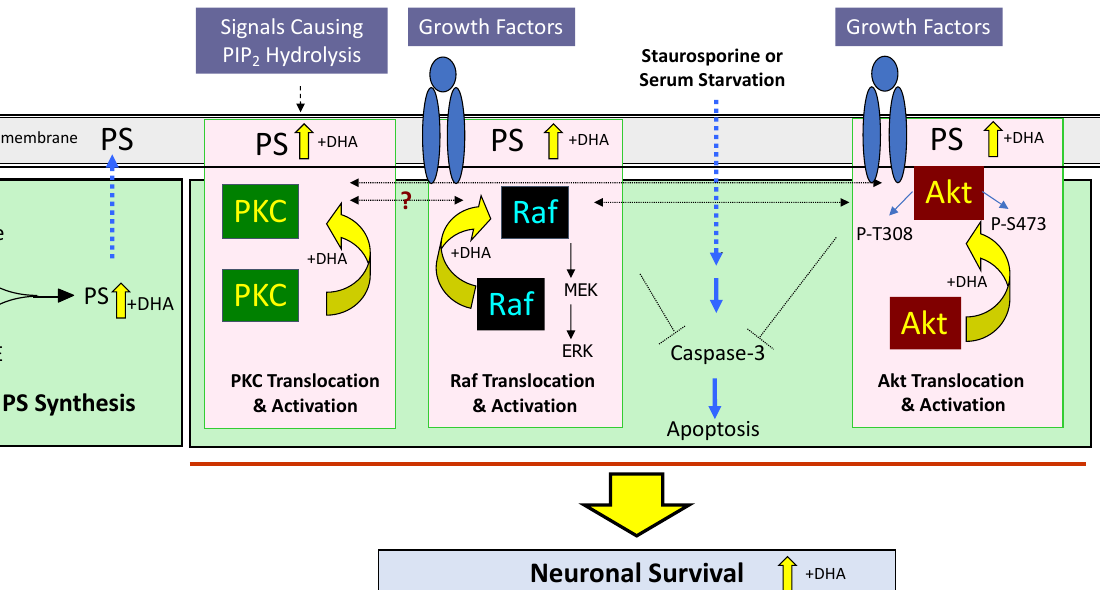
Figure 3. Membrane PS-dependent signaling mechanisms modulated by DHA that mediate neuronal survival under adverse conditions. By increasing PS in the neuronal membrane, DHA facilitates the translocation and activation of PKC, Raf-1, and Akt, positively influencing neuronal survival. PKC, protein kinase C; ERK, mitogen-activated kinase (MAPK); MEK, MAPK kinase. PC, phosphatidylcholine; PE, phosphatidylethanolamine; PS, phsphatidylserine. Adapted from reference [12].